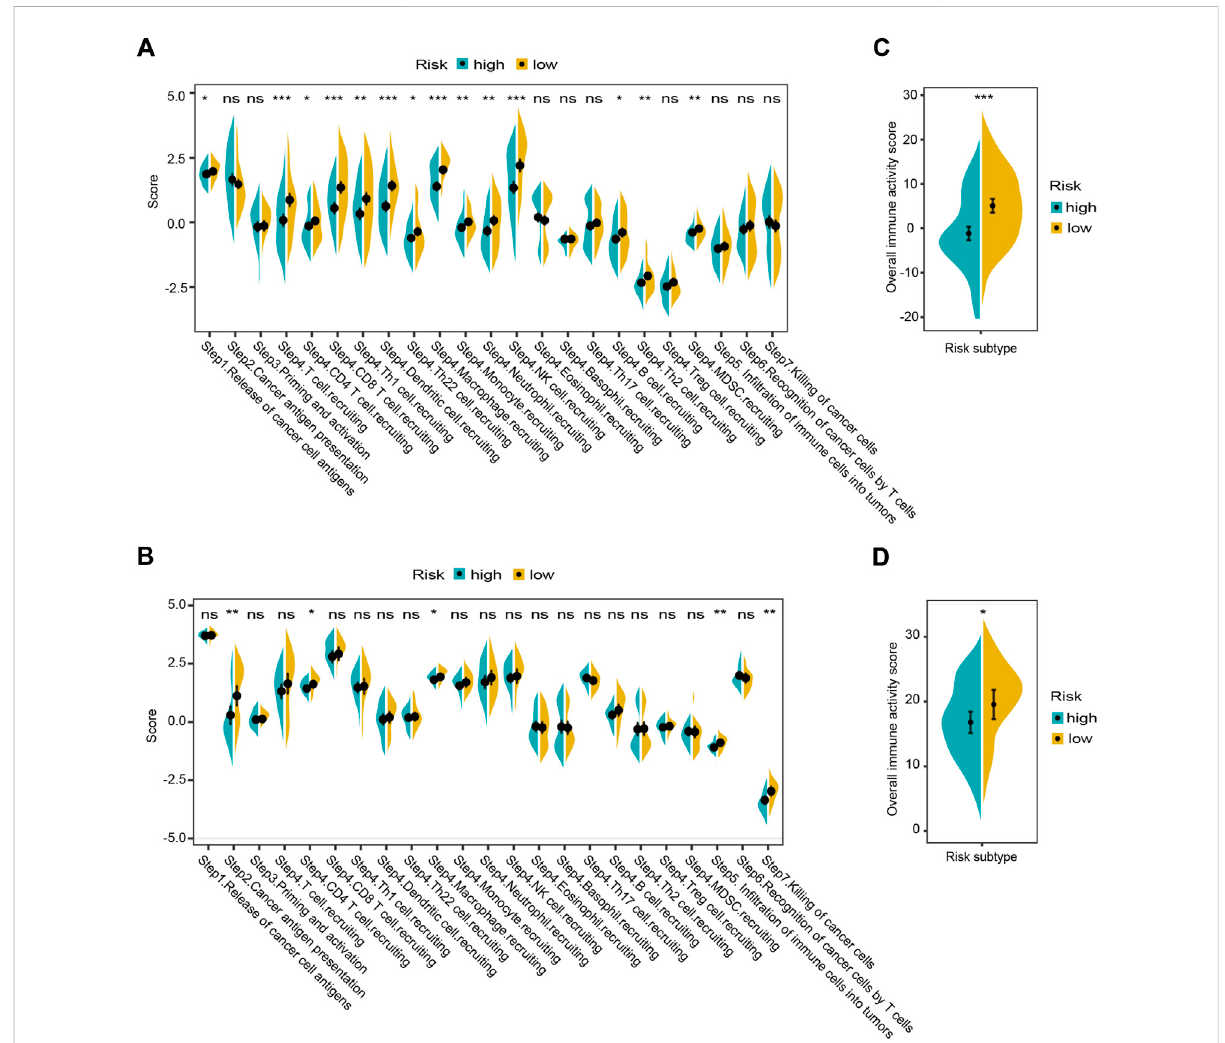
FIGURE 10 Landscapesoftheseven-stepcancer-immunitycyclebetweendifferentriskgroupsintheGSE32062 (A,C) andICGC (B,D)